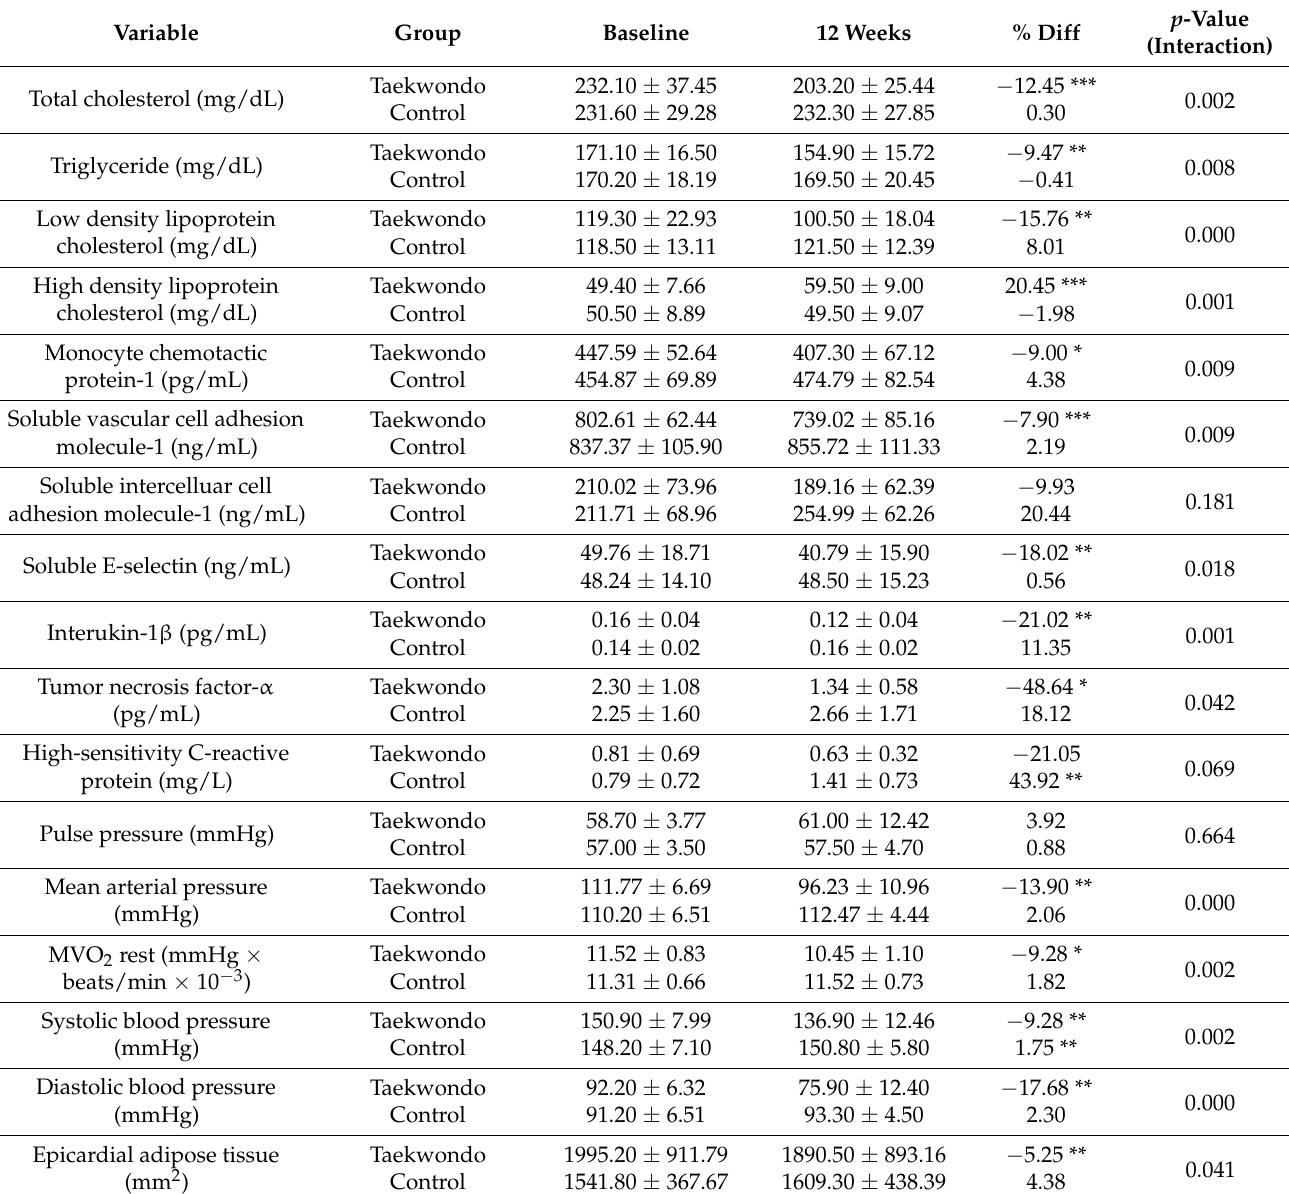
Table 4. The changes of cardiovascular disease risk factor and epicardial adipose tissue between the groups at baseline and after 12